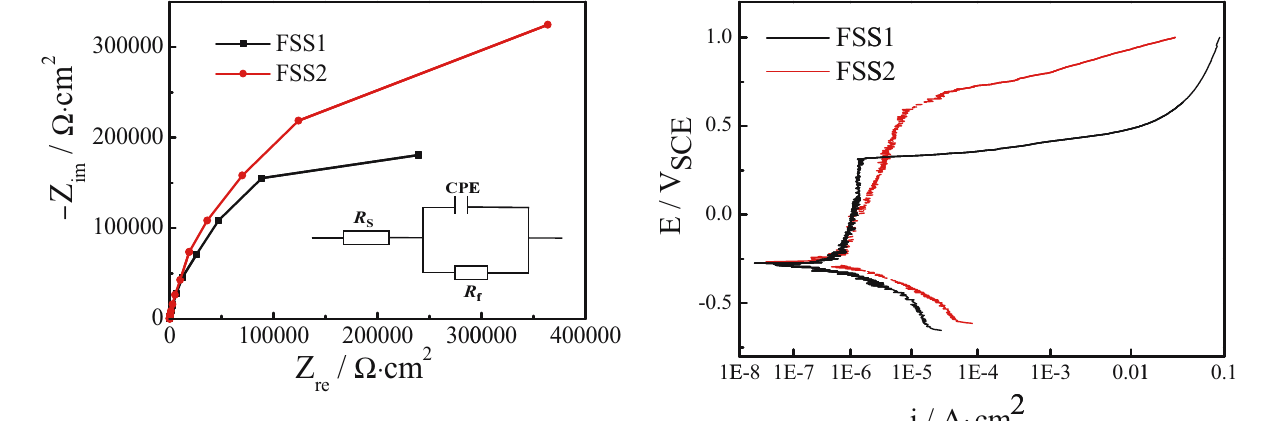
Figure 4: Nyquist plots of experimental steel samples in 10% NaCl solution.